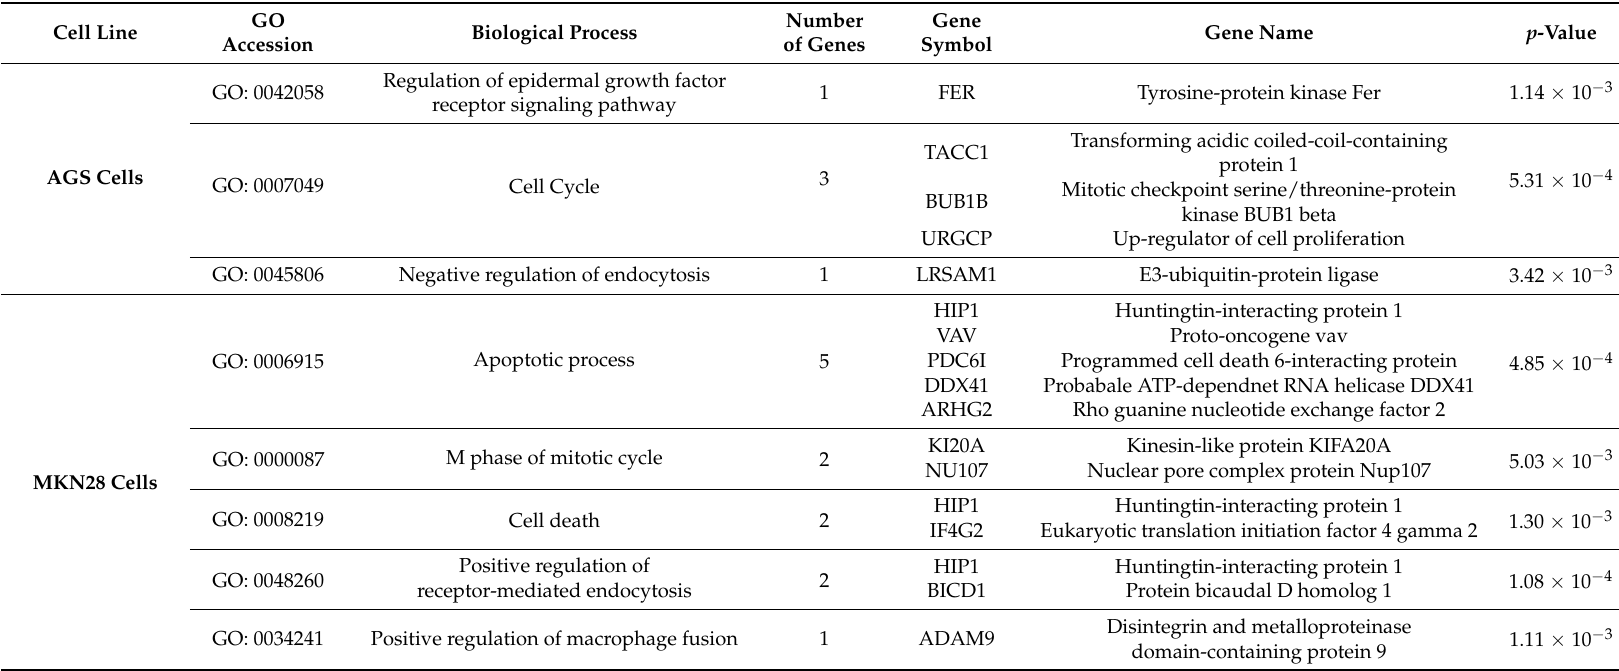
Table 3. List of tumor-associated biological process of differentially expressed genes in AGS and MKN28